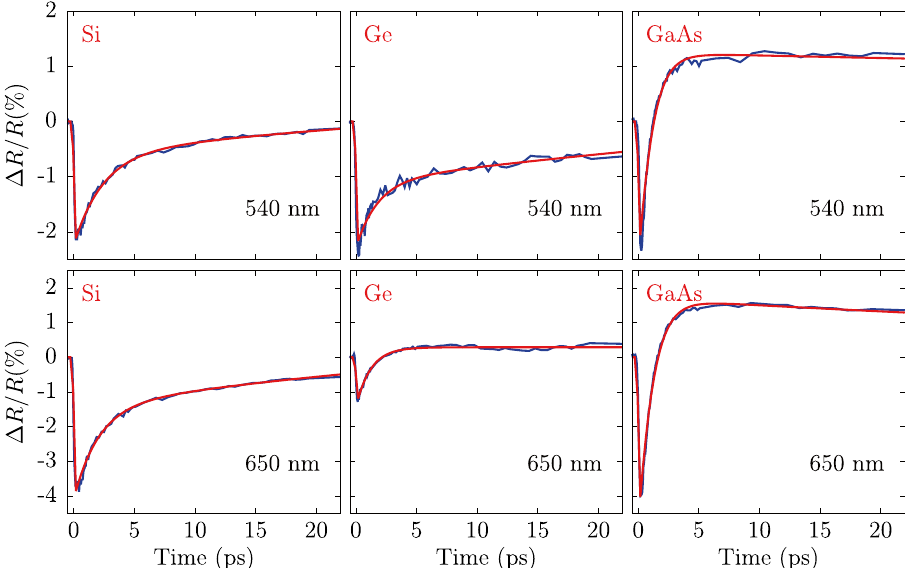
Figure 4. Time evolution of � R / R for Si (left panel), Ge (center panel) and GaAs (right-hand panel) at selected wavelenghts. Experimental data (blue curves) are compared with the results of a simple exponential model. Probe wavelength are 540 nm (upper panels) and 650 nm (lower panels). Pump fluences were 16 mJ/ cm 2 , 16 mJ/ cm 2 and 6.4 mJ/ cm 2 for Si, Ge and GaAs respectively.